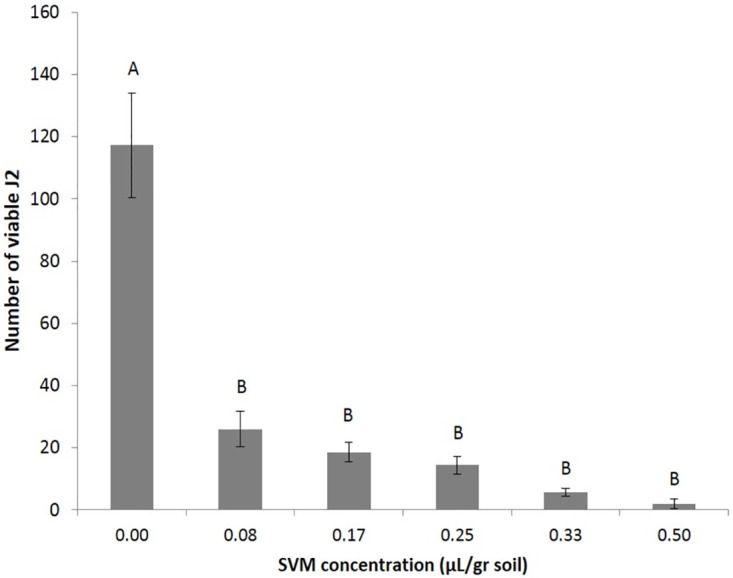
Activity of the SVM in loamy soil.A 0.4 mL stock of SVM [3-methyl-1-butanol (0.08 mL, 0.73 mmole), (±)-2-methyl-1-butanol (0.08 mL, 0.74 mmole), 4-heptanone (0.16 mL, 1.14 mmole), and isoamyl acetate (0.08 mL, 0.54 mmole)] was aliquoted, loaded on perlite particles, and mixed with 60 g of soil in a sealed 50-mL cup, before the addition of 500 J2s. The cups (five repetitions) were sealed and incubated for 48 h, after which viable J2s were determined according to the Baermann funnel method. The numbers on the y-axis represent the means (± SE) of viable J2s extracted from the soil. The results were subjected to analysis of variance followed by the Tukey-Kramer multiple comparison test; different letters above the bars indicate a significant difference between samples at P ≤ 0.05. The experiment was independently repeated twice, each time with similar results.